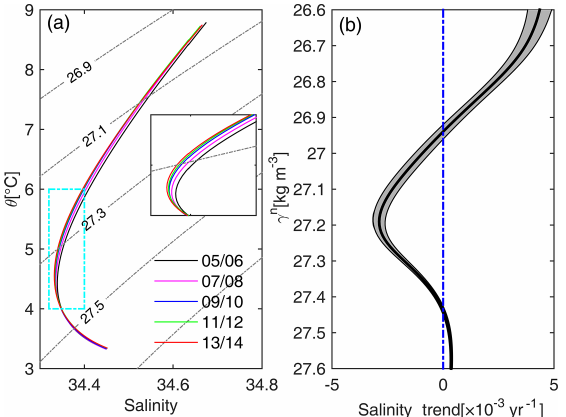
Figure 3. (a) Biennial mean θ – S diagram averaged over Region A for IPRC data with γ n surfaces superimposed (grey solid–dotted lines). The inserted figure is the magnification of the area delin- eated by cyan solid–dotted box. The corresponding time for each θ – S curve is listed in their bottom-right corner (i.e. 05/06 for 2005– 2006). (b) Salinity trend along γ n surfaces for period January 2005– December 2014 is displayed by the thick black line, and the 95% confidence intervals ( F -test) are represented by the light grey shad- ings, calculated from IPRC data.